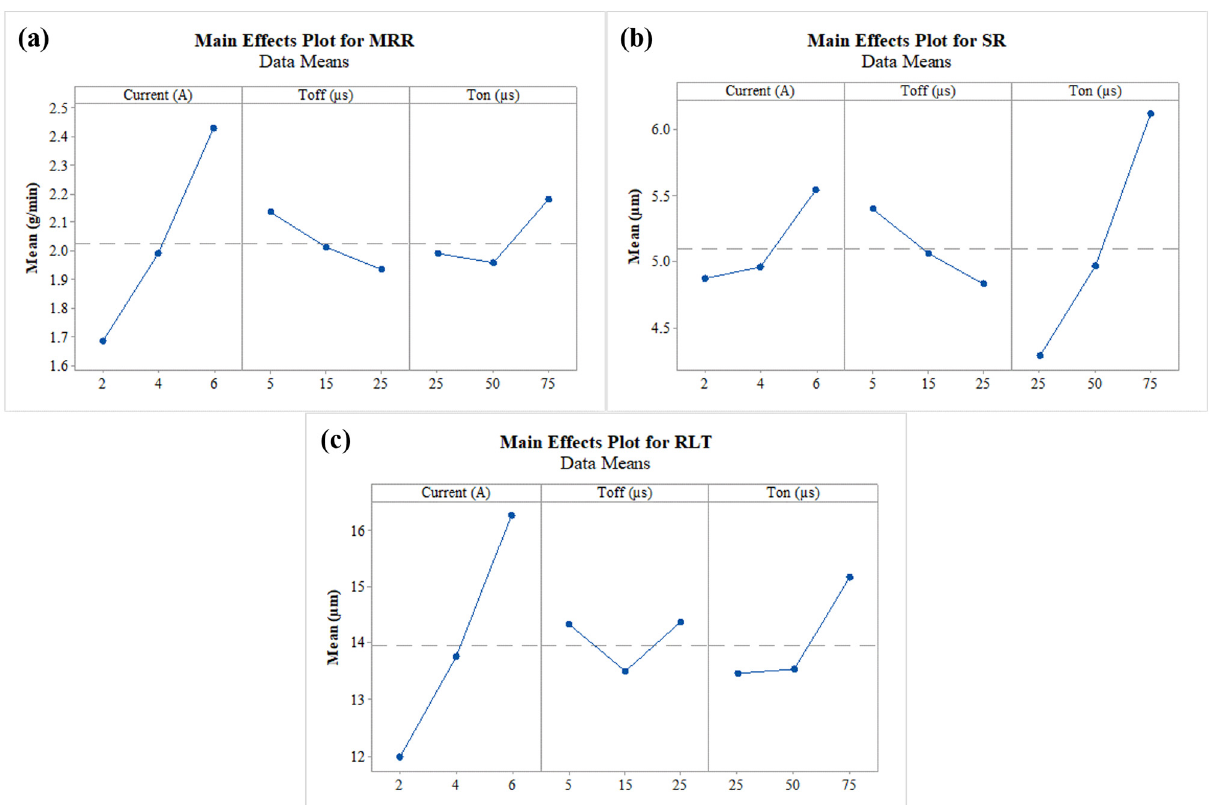
Figure 8. Main effect plot for ( a ) MRR, ( b ) SR, and ( c ) RLT.